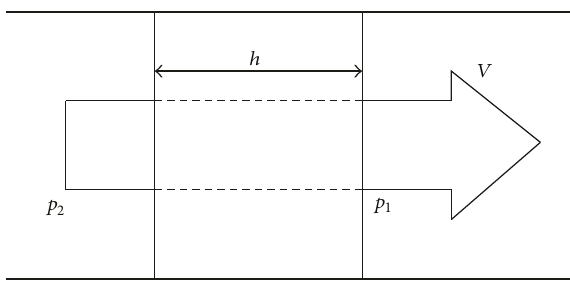
Figure 3: A differential pressure 𝑝 2 −𝑝 1 induces steady airflow 𝑉 of air per unit area of